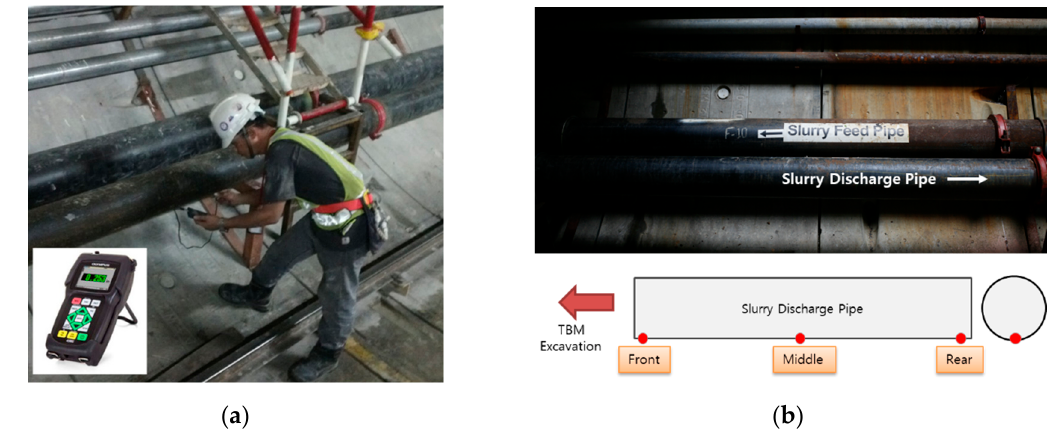
Figure 6. Thickness measurement of slurry discharge pipes: ( a ) pipe thickness measurement; ( b ) measurement point.